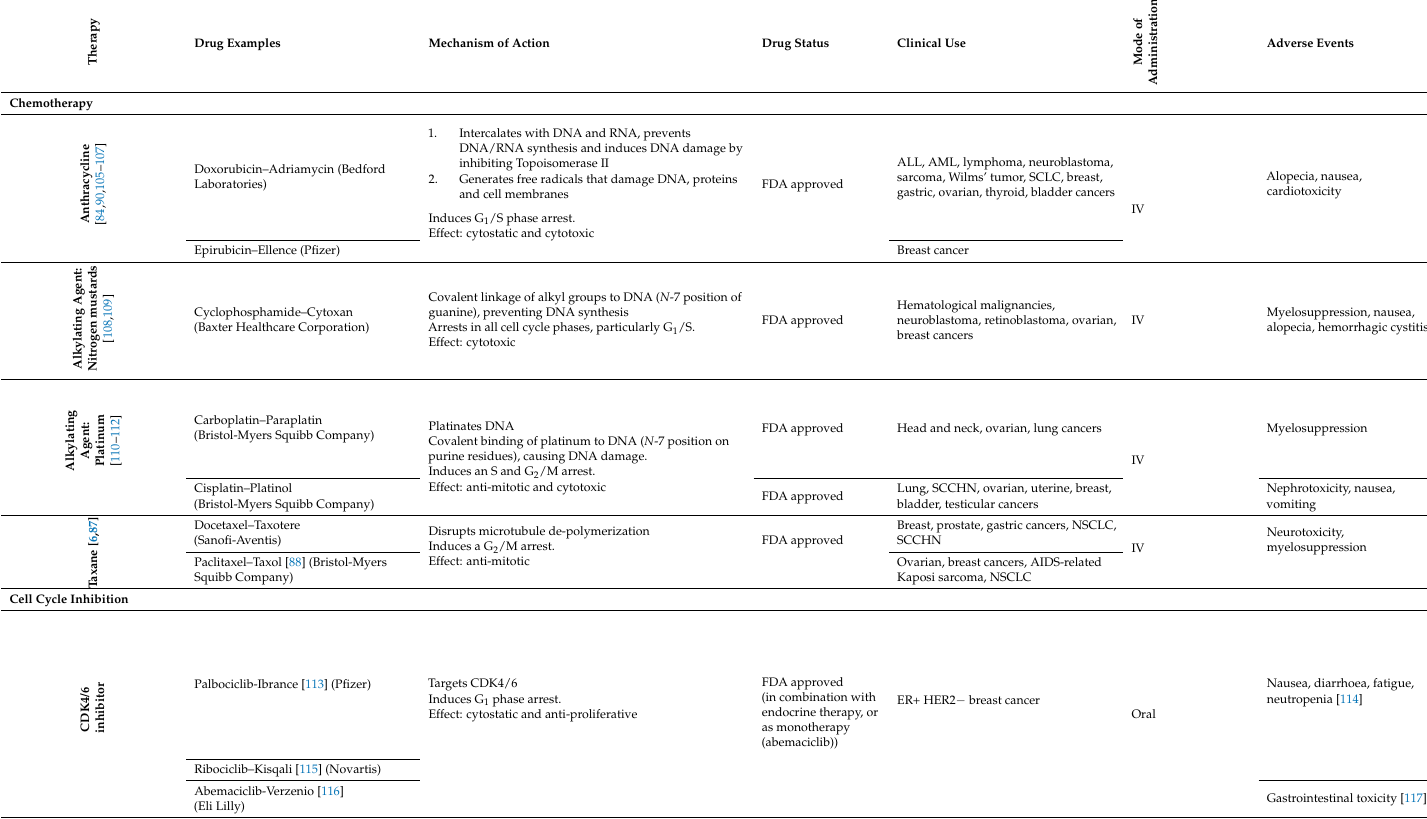
Table 1. Cell cycle directed therapies for